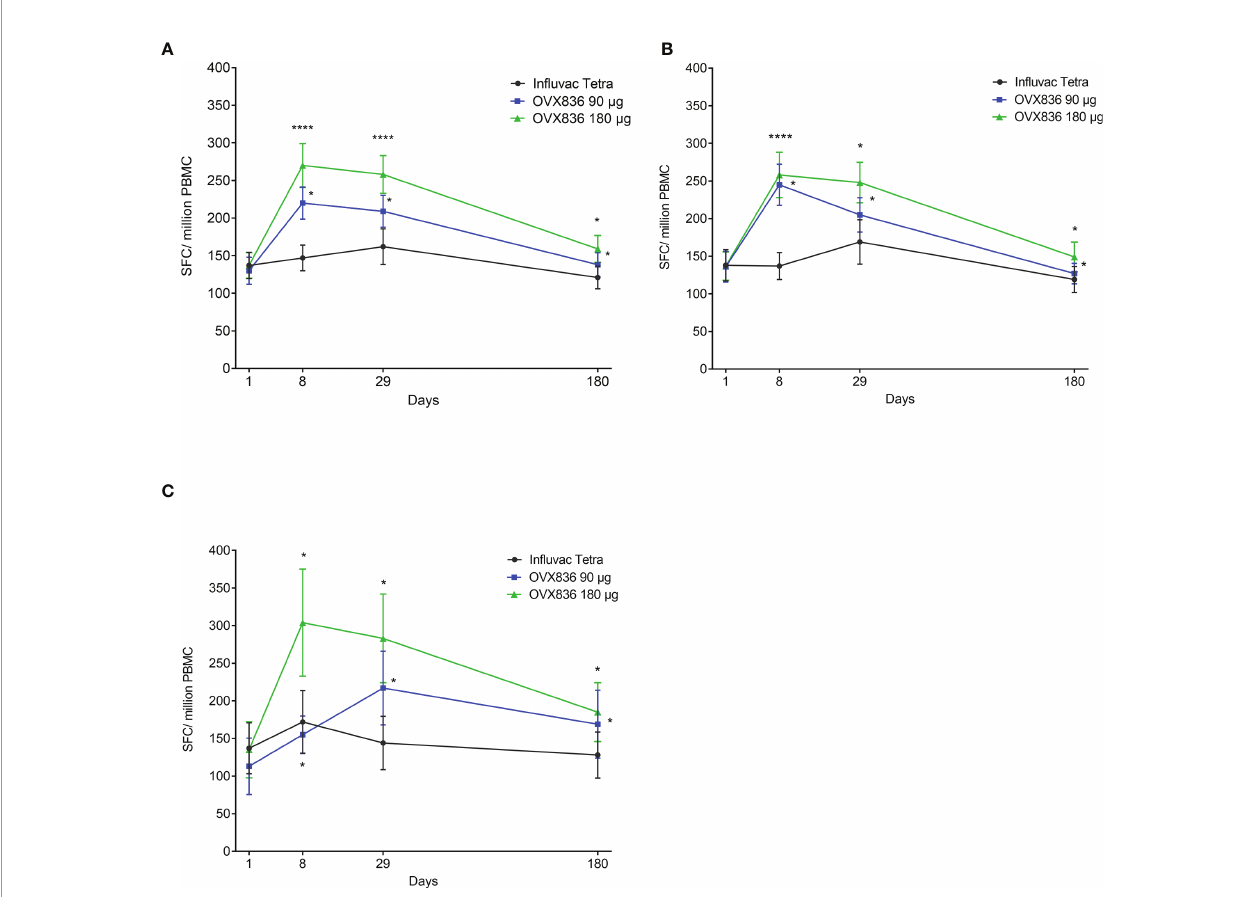
FIGURE 1 | Evolution over time of the number of nucleoprotein (NP)-speci fi c interferon-gamma (IFN g ) spot forming cells (SFCs) per million of peripheral blood mononuclear cells (PBMC) between baseline (Day 1 – pre-vaccination) and Day 180 (post-vaccination) in the three treatment groups (In fl uvac Tetra ™ , OVX836 90µg and OVX836 180µg; per protocol cohort). Results are shown as mean ± standard error; paired comparisons between each timepoint post-vaccination and baseline (Day 1): *p<0.05; ****p<0.0001. Panel (A) corresponds to all subjects, Panel (B) to subjects aged 18-49 years and Panel (C) to subjects aged 50-65